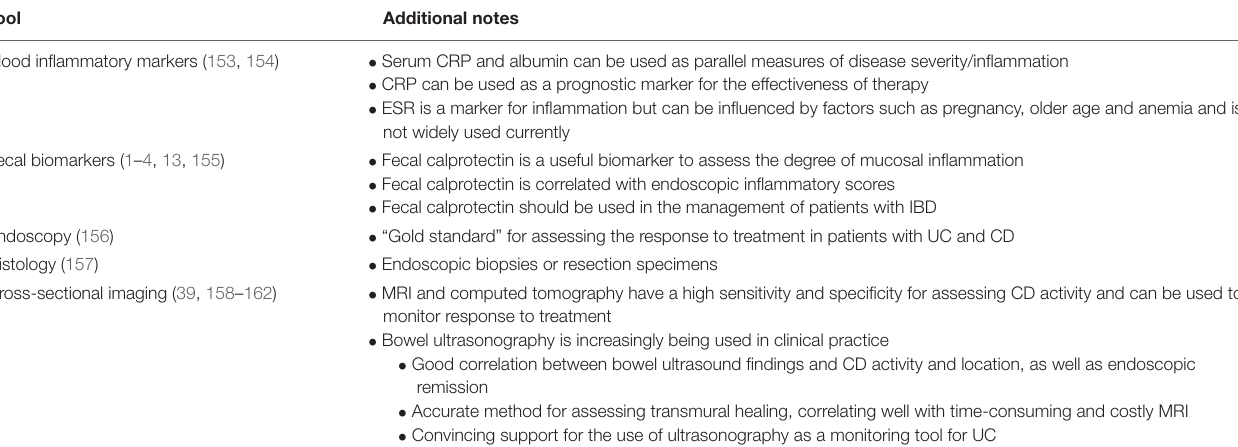
TABLE 1 | Available tools for assessing the level of disease-associated inflammatory activity.